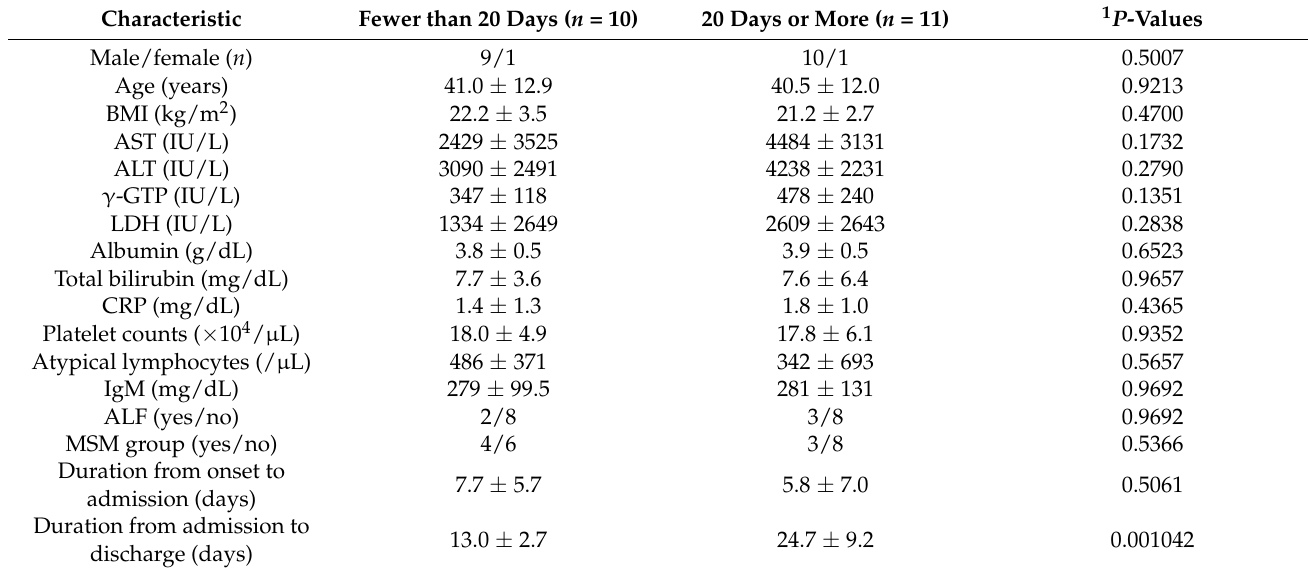
Table 4. Clinical characteristics between patients with admission for less than 20 days and those with admission for 20 days or